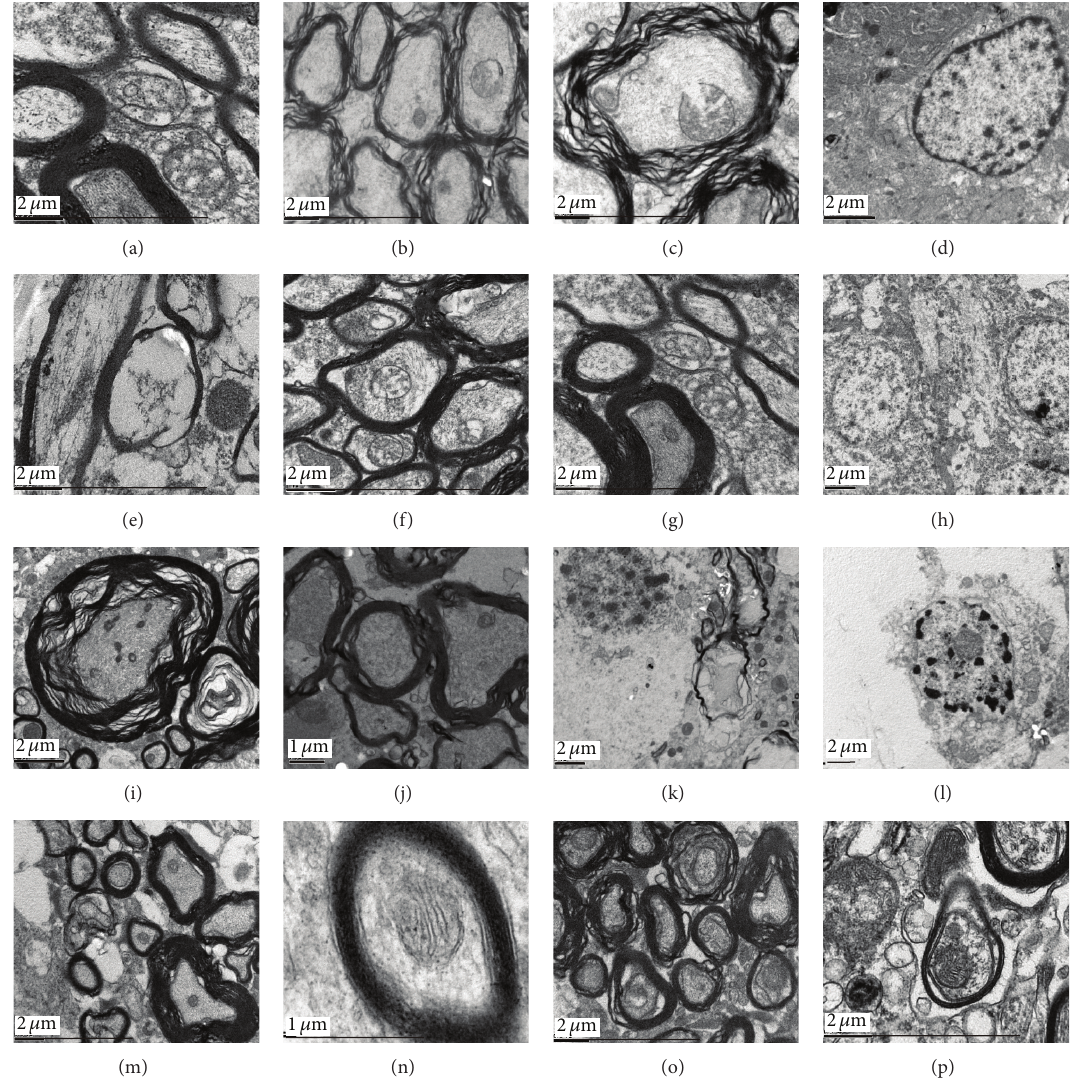
Figure 6: Electron micrograph demonstrated prevention of myelination or axons loss and inhibition of neuronal apoptosis in C16 treated rats. (a) Normal rats group (normal myelinated axons exhibited dark-rings-shaped myelin sheath surrounding axon). ((b)–(d)) Vehicle control rats at week 2 after immunization. A considerable amount of the myelin sheath displayed splitting, vacuolus, and loose and fused change, and the axon is shrunken and is dissolving ((b), (c)). The neuron showed apoptotic signs of a shrunken nucleus with condensed, fragmented, and marginated nuclear chromatin (d). At week 2 after immunization, 0.5 mg (e), 1mg (f), and 2 mg ((g), (h))/per day C16 treated EAE rats. Some vacuolated and fused myelin sheaths were observed, but most of dark-rings-shaped myelin sheath structure has been kept ((f), (g)); the ultrastructure of neuron was still kept relatively normal (h). Visible myelin lamella cleavage, splitting, and fragmentation were detected in C16 late treated EAE rats (i). ((j)–(l)) Vehicle control rats at week 8 after immunization. Many myelin lamellae were still undergoing vesicular disintegration, but some were remyelinated; invasion of a myelin sheath by a macrophage containing myelin debris was illustrated in (k), and apoptotic neurons could be found in (l). ((m), (n)) 2mg/per day C16 treated EAE rats at week 2 after immunization, (n) illustrating a rescued axons with a intact myelin. ((o), (p)) C16 late treated EAE rats at week 8 after immunization. More fibers were being remyelinated in these C16 treated animals, (p) showing newly formed myelin